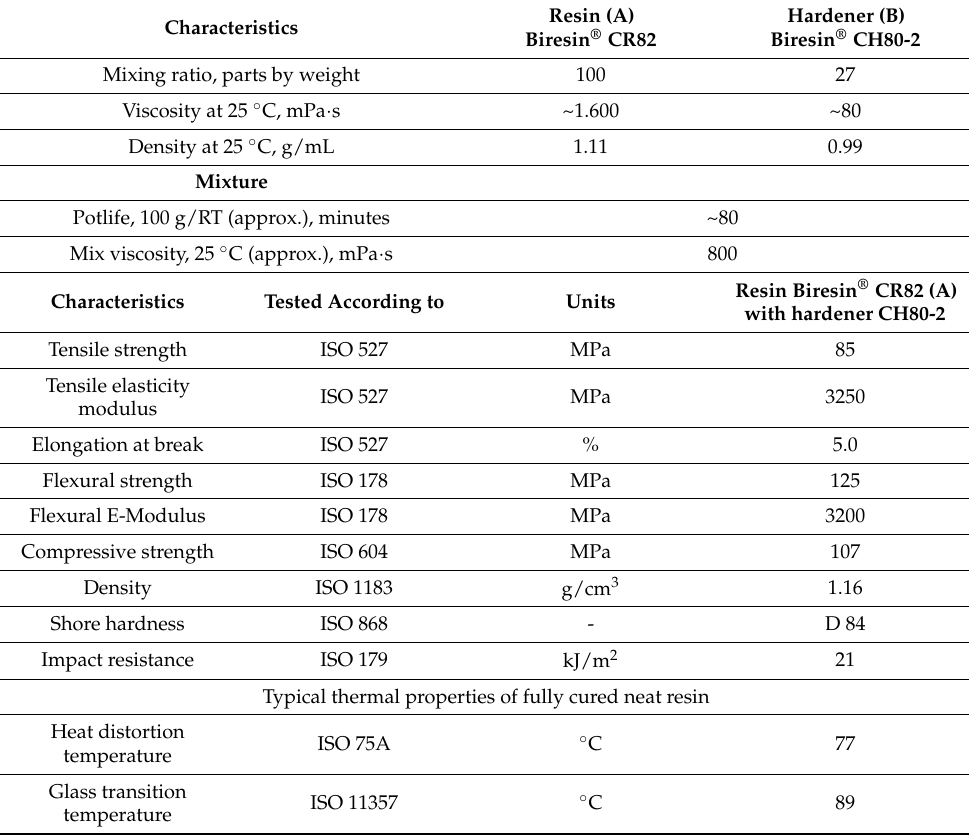
Table 3. Characteristics of resin Biresin ® CR82 and hardener Biresin ® CH80-2 [39].